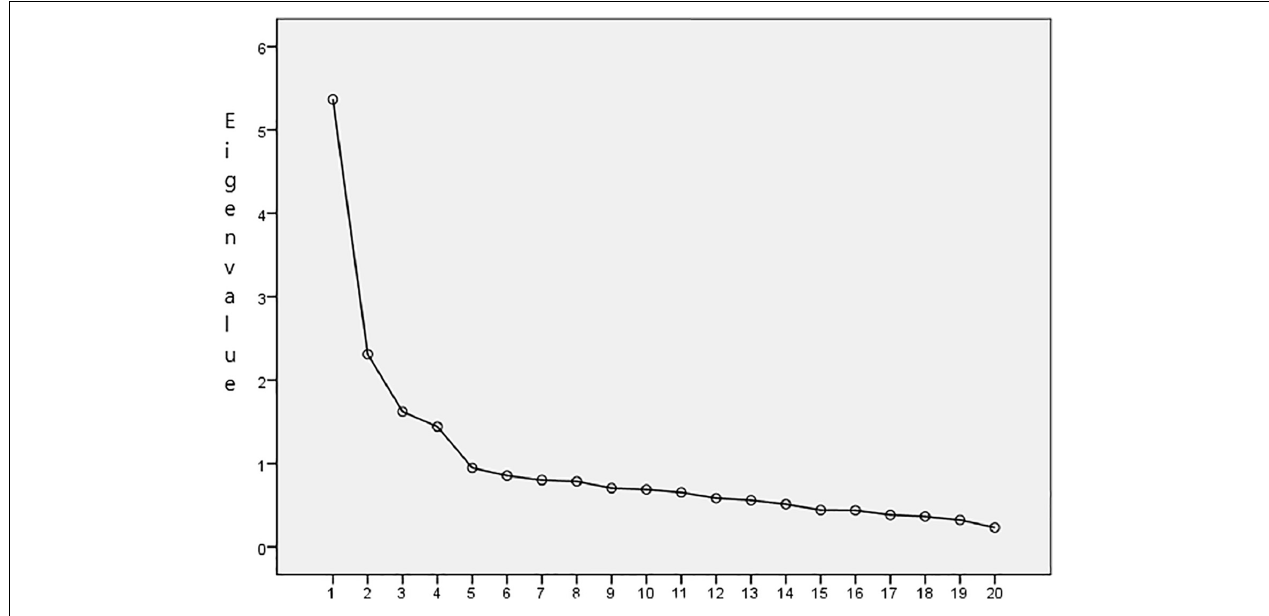
FIGURE 1 | The scree